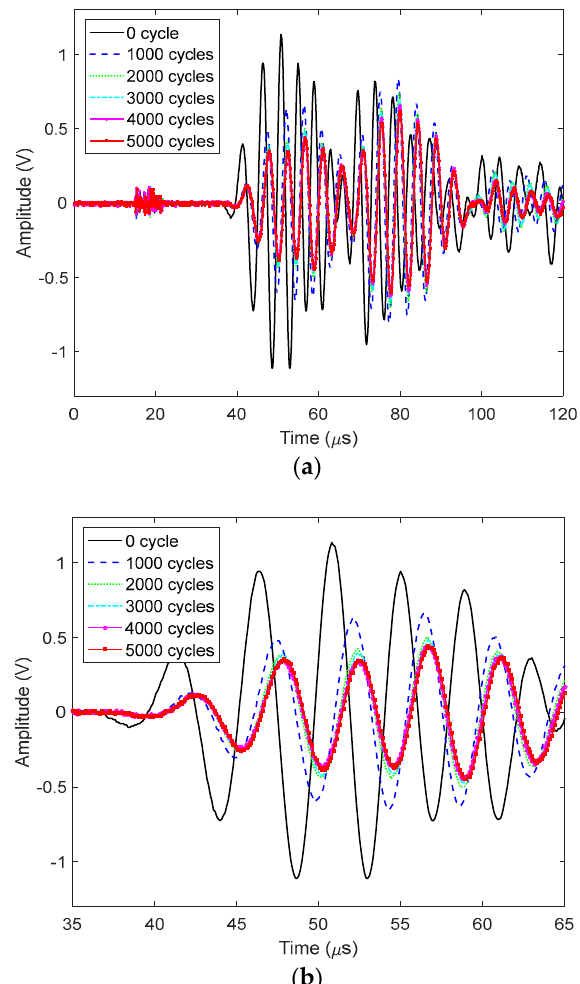
Figure 4. Response wave signals after different fatigue cycles for specimen S_A: ( a ) six signals and ( b ) zoomed signals.